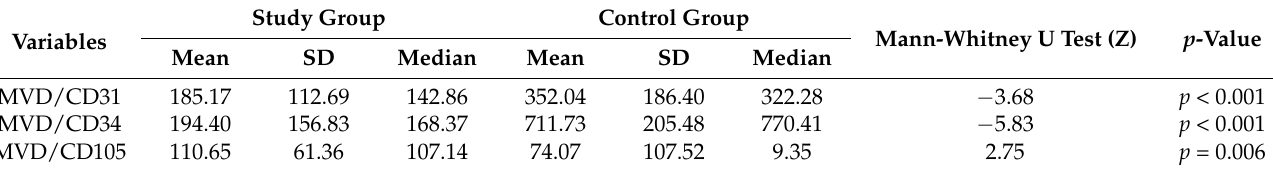
Table 3. Microvessel density (MVD) evaluation based on the expression of selected endothelial markers in the study group and in the control group (Mann–Whitney U Test).